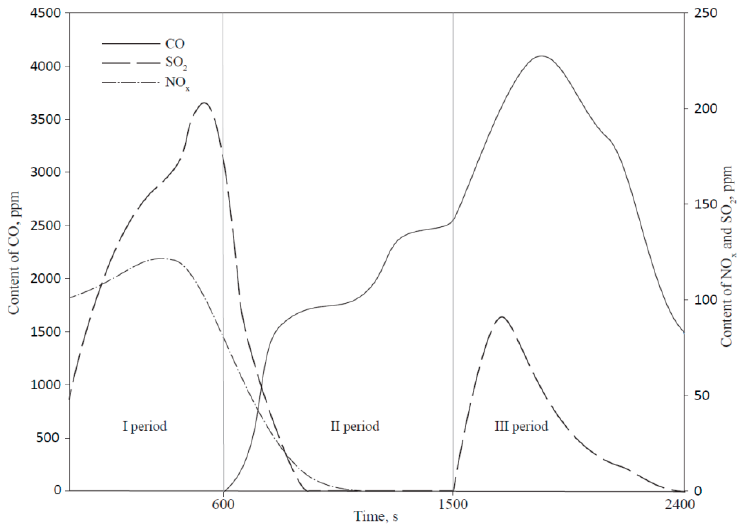
Figure 11. Emission of CO, NO x , and SO 2 in three periods of the smelting process.